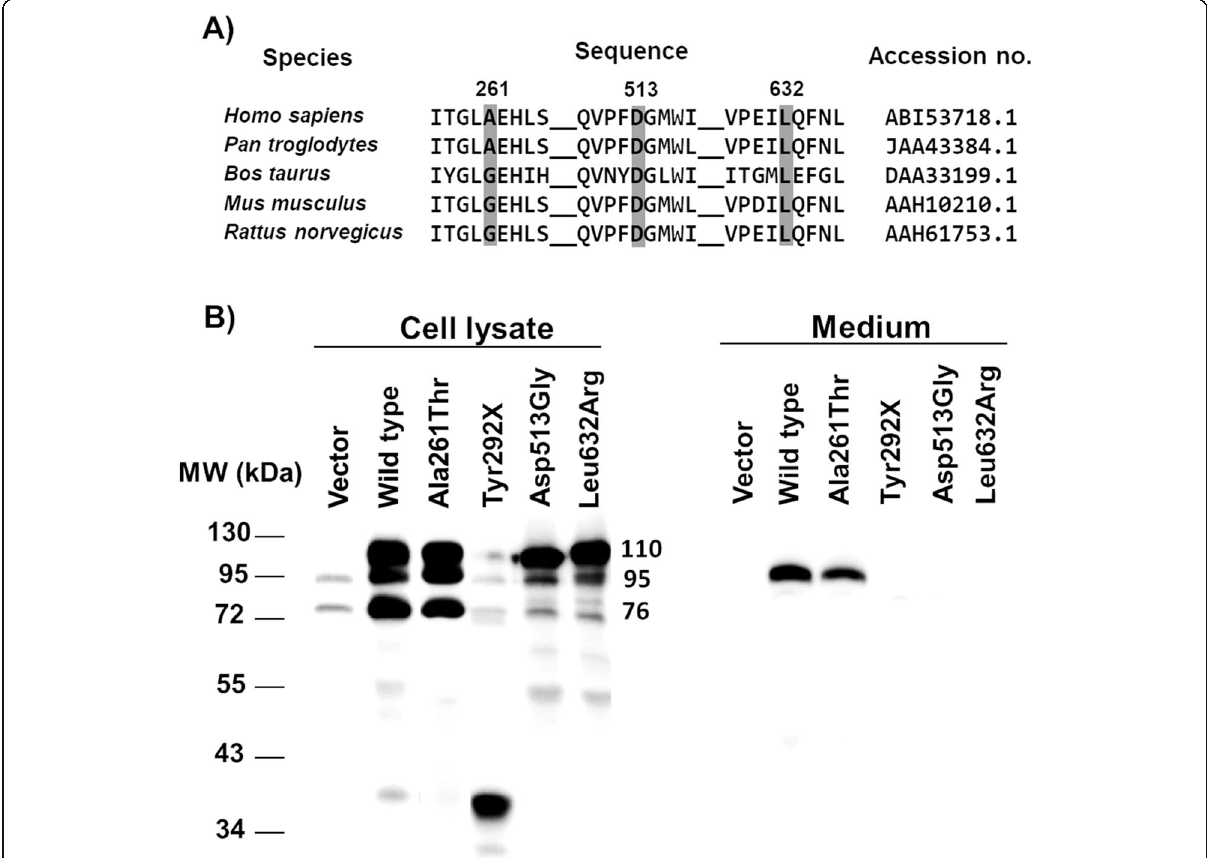
Fig. 1 GAA protein analysis. a Protein sequence alignment of vertebrate GAA. b Western blot analysis of GAA protein in the wild type and